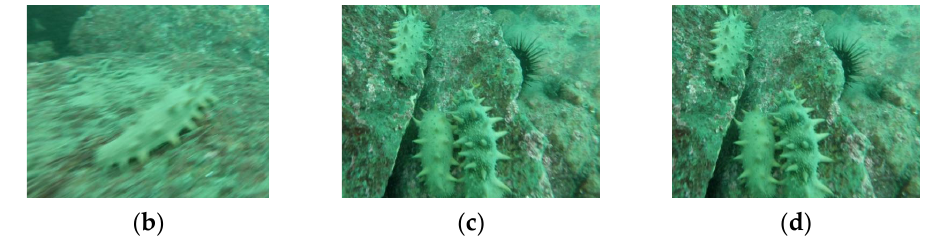
Figure 2. ( a – d ) Partial sea cucumber images.